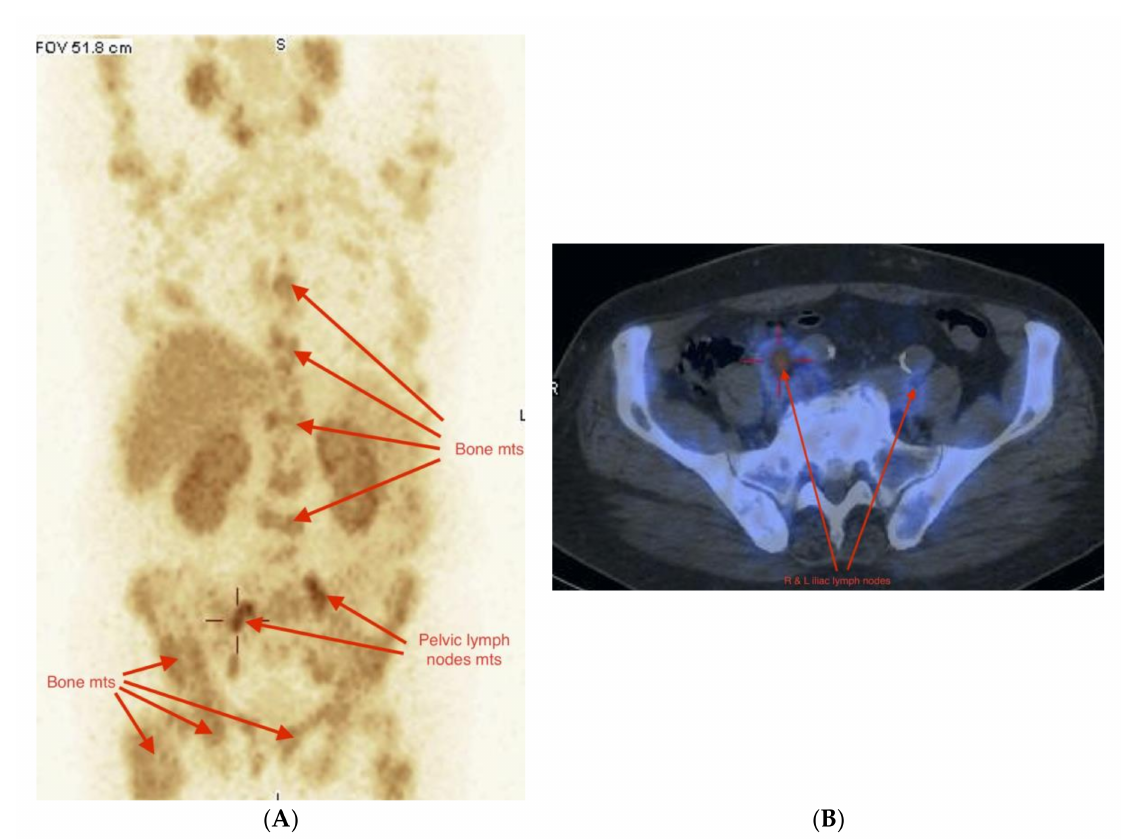
Figure 5. ( A , B ) Male 71 years, non-resectable PCa GlS = 9 (4 + 5), cTxN1M1, PSA = 7.2 ng/mL. During palliative hormonal and chemotherapy. Multiple bone mets and bilateral pelvic lymph nodes involvement in WB-SPECT/CT [ 99m Tc]Tc-PSMA-T4 evaluation of stage of disease. ( A ) WB-SPECT/CT, right and left enlarged pelvic lymph nodes and multiple bone mets in WB-SPECT (MIP) scan. ( B ) Osteosclerotic pelvic bone mets with pathological uptake of [ 99m